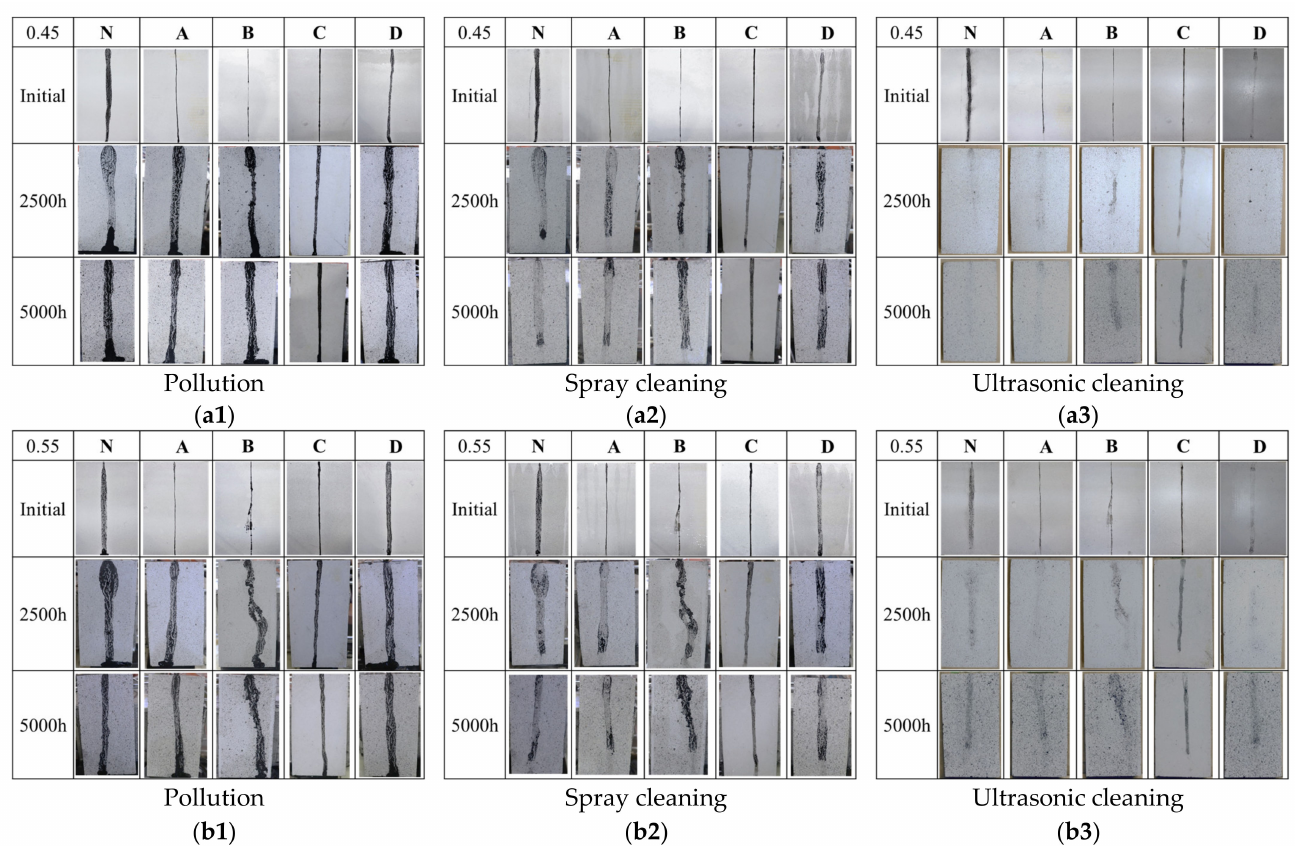
Figure 9. The Visual Observation of the uncoated and coated specimens after pollution ( a1 , b1 ), spray cleaning ( a2 , b2 ) and ultrasonic cleaning ( a3 , b3 ), w/c ratio 0.45 ( a1 , a2 , a3 ), 0.55 ( b1 , b2 , b3 ) of accelerated soiling